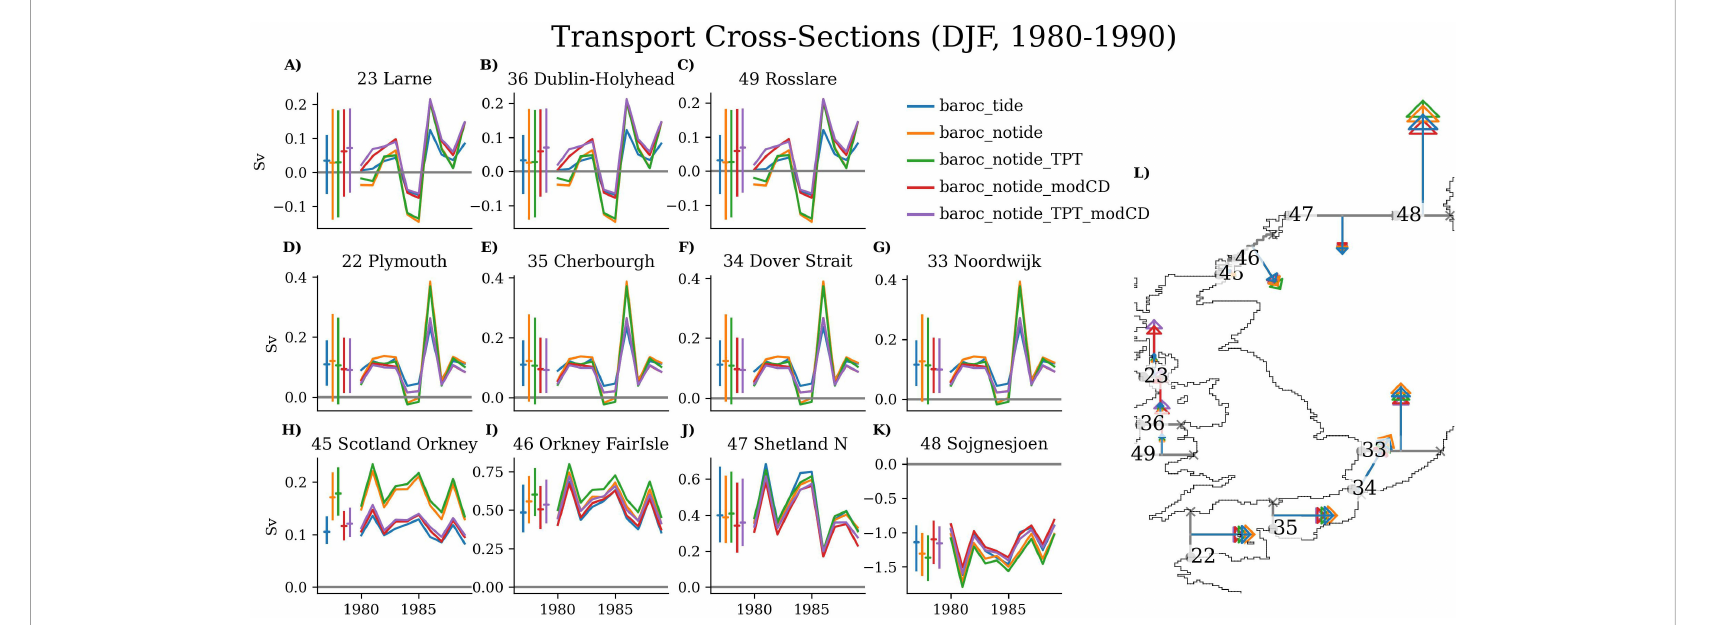
FIGURE 3 NWS Winter (DJF) volume transport time-series through selected cross-sections (A – K) . (L) map showing volume cross-section locations, with coloured arrows showing the direction and relative magnitude of transport for each of the model simulations. Left hand panels (A – K) volume transport time series through cross-sections in (L) . To the left of each time series is a series of crosses, denoting the time series mean, and 5 th and 95 th percentiles. (A – C) Irish Sea cross-sections, (D – G) English Channel cross-sections, (H – K) northern North Sea in fl ow/out fl ow